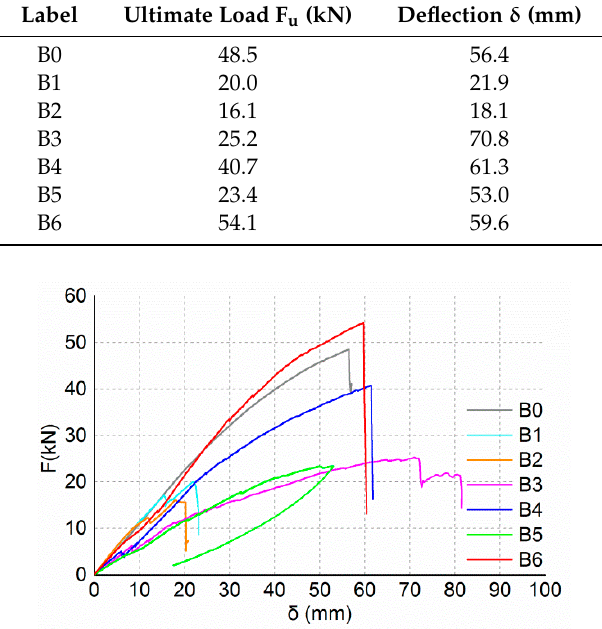
Figure 7. Load–deflection curves of bending beams.